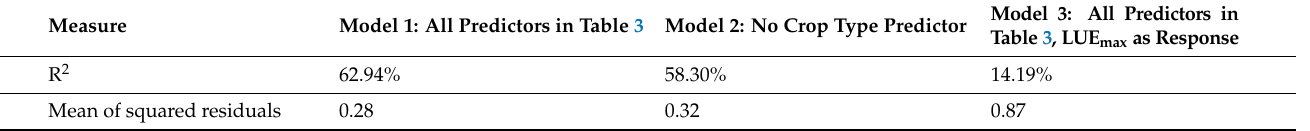
Table 4. Performance of random forest prediction models for light use efficiency (LUE) (Models 1 and 2) and LUE max (Model 3) expressed as percentage of variation in LUE in situ or LUE max in situ explained by variation in out-of-bag predictions (R 2 ) for LUE/LUE max and mean of squared residuals.